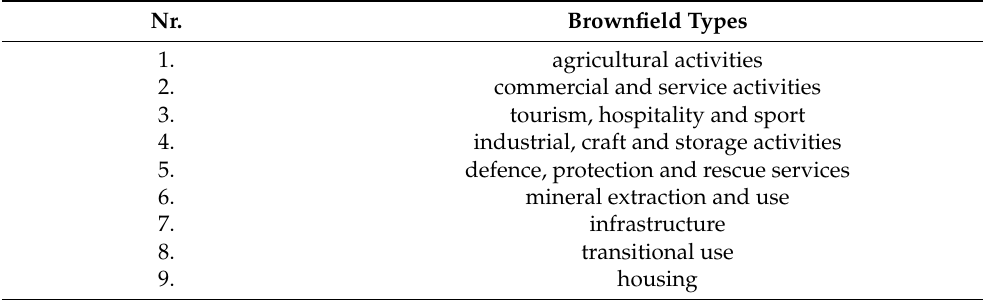
Table 1. Slovenian brownfield typology as the basis for the comparison [5]. Nr.